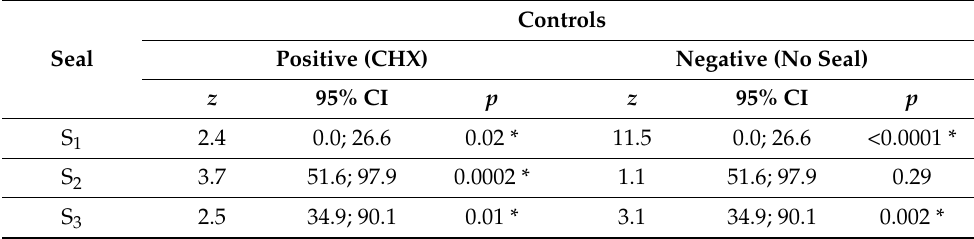
Table 3. Comparison between sealant materials and control groups with regard to Candida spp. infection.